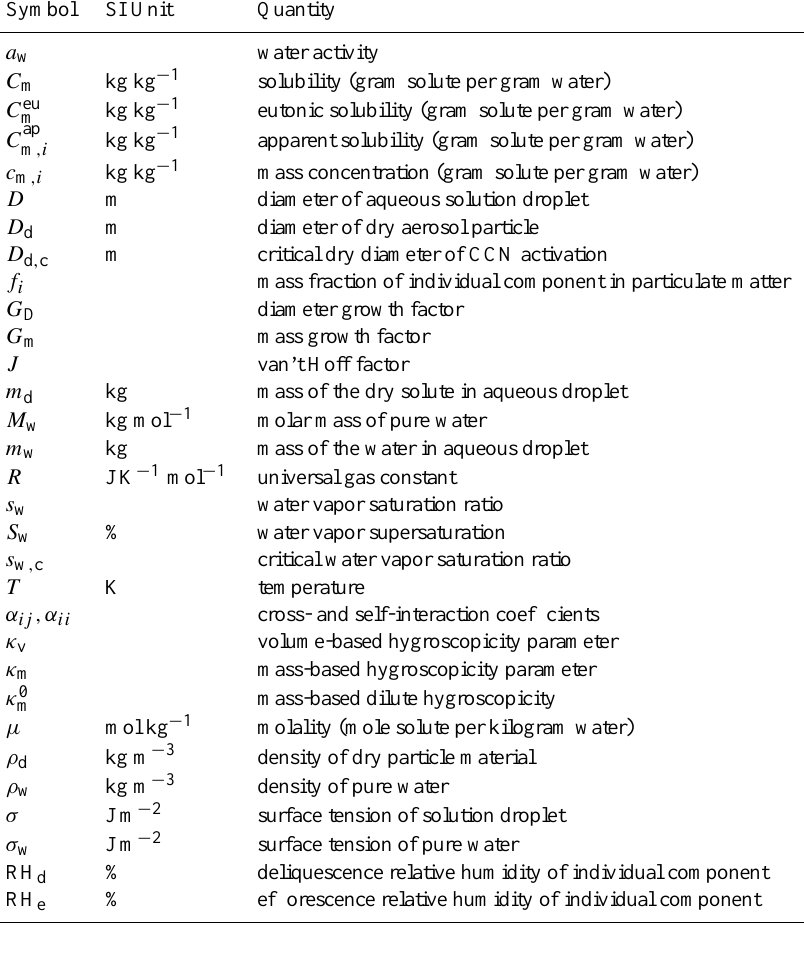
Table 1. Frequently used